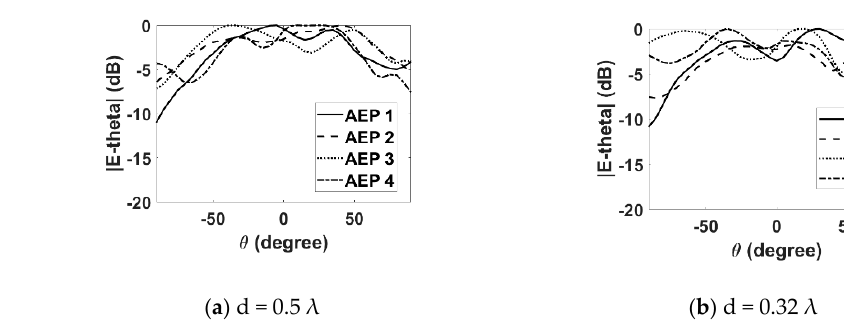
Figure 8. Measured active element patterns (E plane).